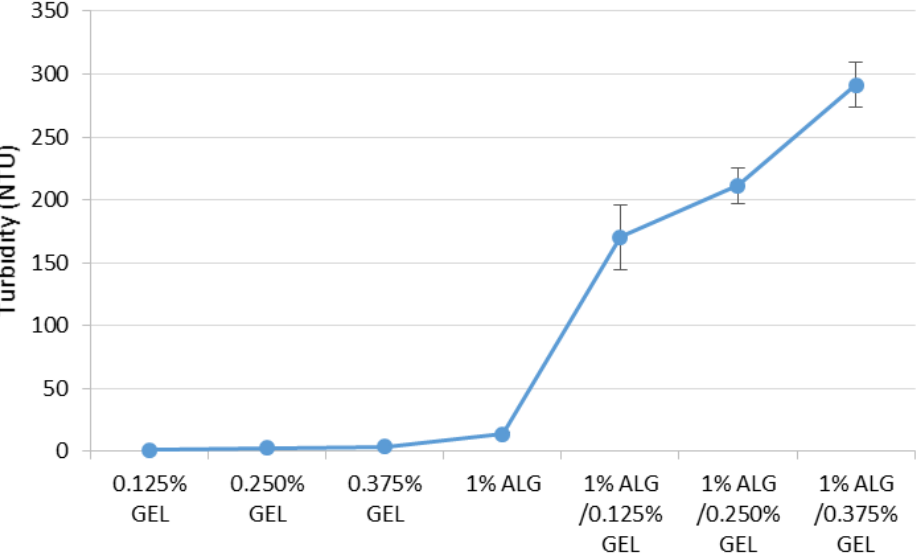
Figure 3. Turbidity values of 0.125%, 0.250%, 0.375% GEL, 1% ALG, and ALG/GEL PECs mixtures with regard to various polyanion/polycation ratios.